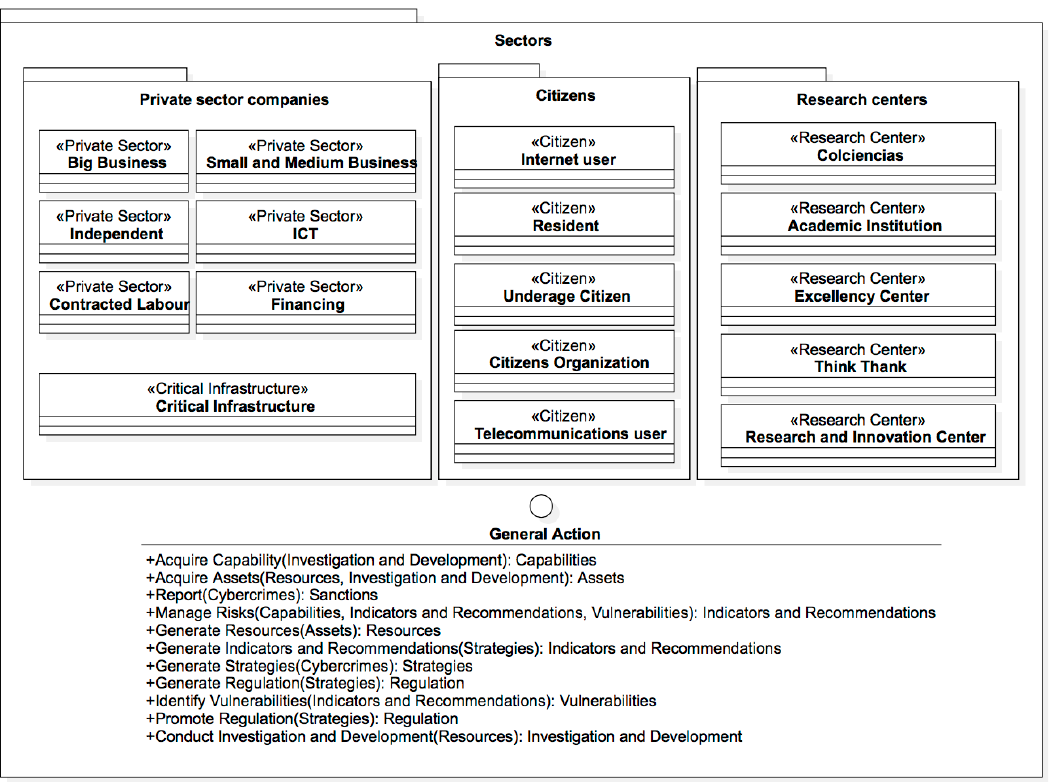
Figure 17. Sectors. Figure 17. Sectors.